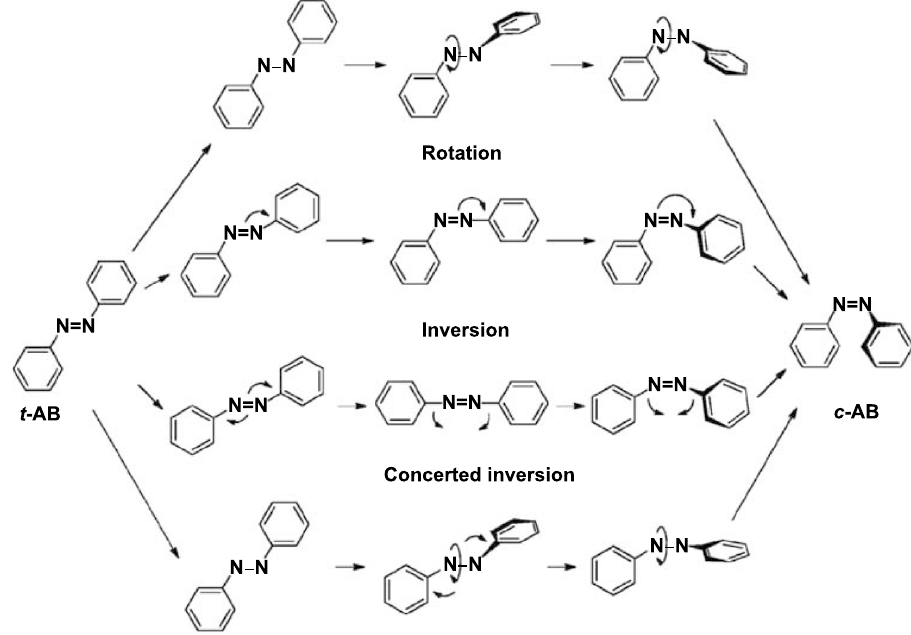
Fig. 2 Four known mechanisms for azobenzene trans to cis isomerization